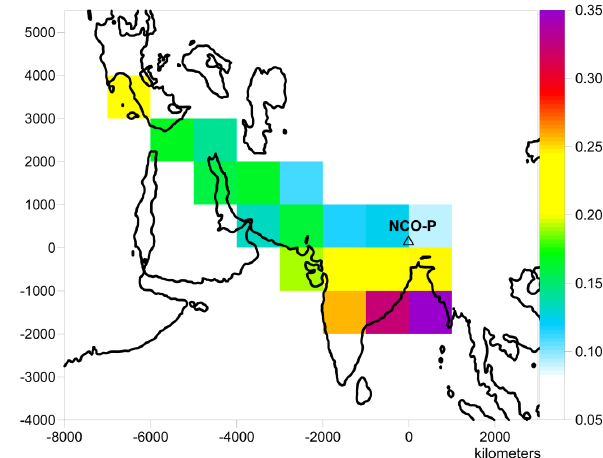
Fig. 6. Map of conditional probability of potential sources of an- thropogenic halocarbons, based on observations at NCO-P observa- tory. The scale represents the fraction of polluted trajectories over total ones.